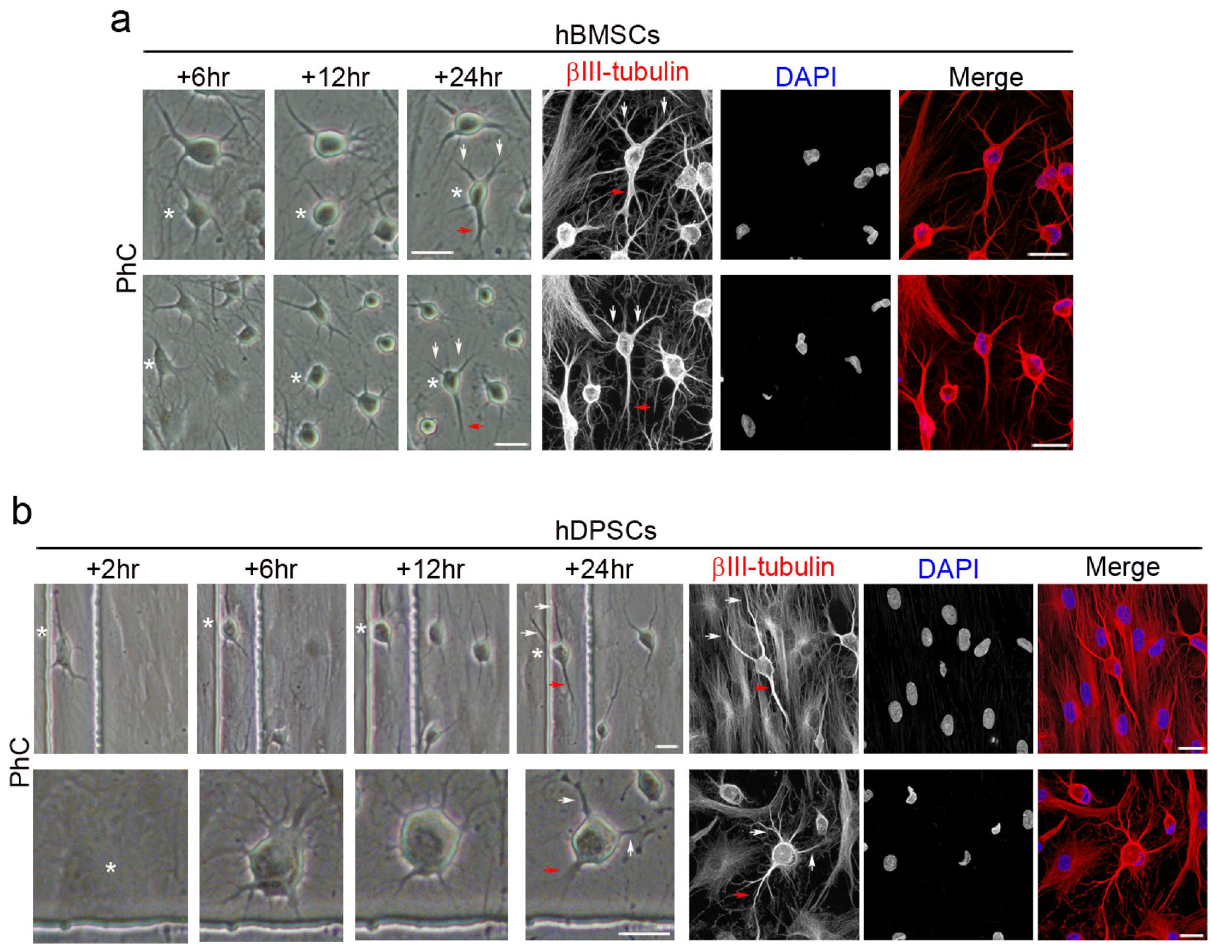
Figure 4. Early stages of neuronal polarisation of hBMSC-derived and hDPSC-derived neuron-like cells. Time-lapse imaging and immunocytochemical analysis revealed that hBMSC-derived ( a ) and hDPSC-derived neuron-like cells ( b ) gradually adopted a complex morphology, acquiring dendrite-like (white arrows) and axon-like identities (red arrows). Scale bar: 25 μm. PhC: Phase-contrast